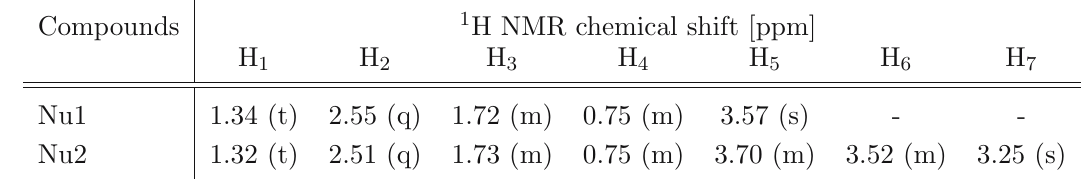
Table 1 1 H NMR chemical shifts of silicon-sulfur podands.